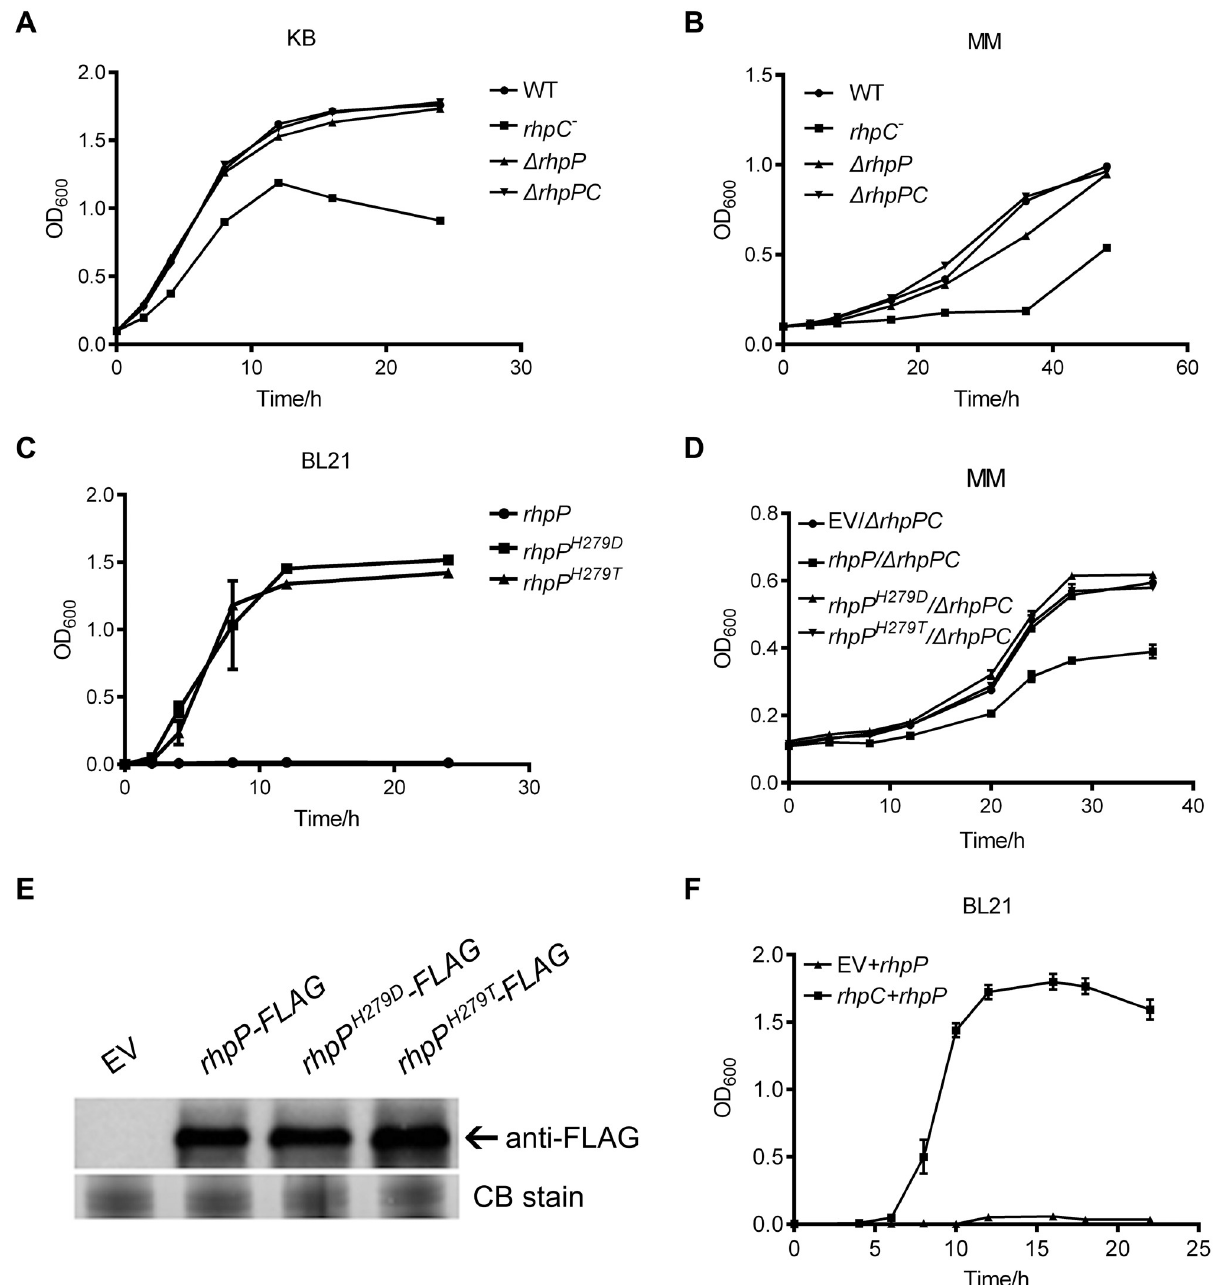
Fig 7. The detrimental effect of RhpP on bacterial growth was abolished by mutations of protease active sites and inhibited by RhpC. (A) and (B) Growth curves of the wild type Psph , Δ rhpC , Δ rhpP , and Δ rhpPC strains in KB (A) and MM (B). (C) Growth curves of E . coli BL21 strains expressing the wild type RhpP-MBP and the mutant RhpP H279D -MBP and RhpP H279T -MBP proteins. (D) Growth curves of Δ rhpPC mutant strains carrying the empty pHM1 vector or pHM1 expressing RhpP-FLAG, RhpP H279D -FLAG, and RhpP H279T -FLAG proteins in MM. (E) RhpP-FLAG, RhpP H279D -FLAG, and RhpP H279T -FLAG proteins expressed by the pHM1 plasmid in Δ rhpPC mutant. Equal amounts of bacterial cells were boiled in SDS sample buffer and analyzed using Western blot with anti-FLAG antibody. (F) Growth of the BL21 strain carrying pMAL:: rhpP-MBP and pHM1 empty vector, or carrying pMAL:: rhpP-MBP and pHM1:: rhpC in LB. EV, empty vector; CB stain, Coomassie Blue stain.